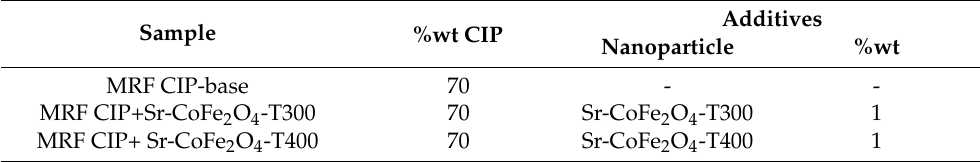
Table 1. The composition of MRF Samples.